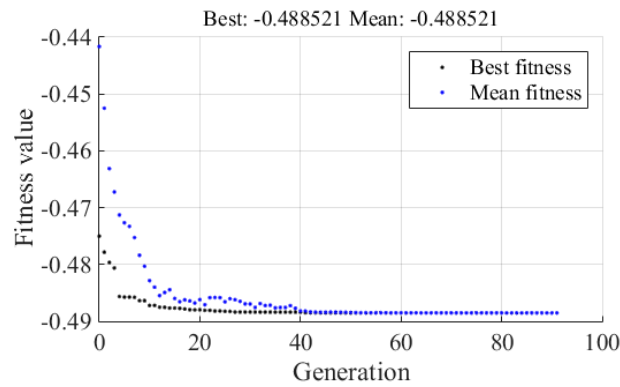
Figure 14. Convergence of the fitness function using the genetic algorithm. Table 5. Design variables employed for the current study with the upper and lower bounds.